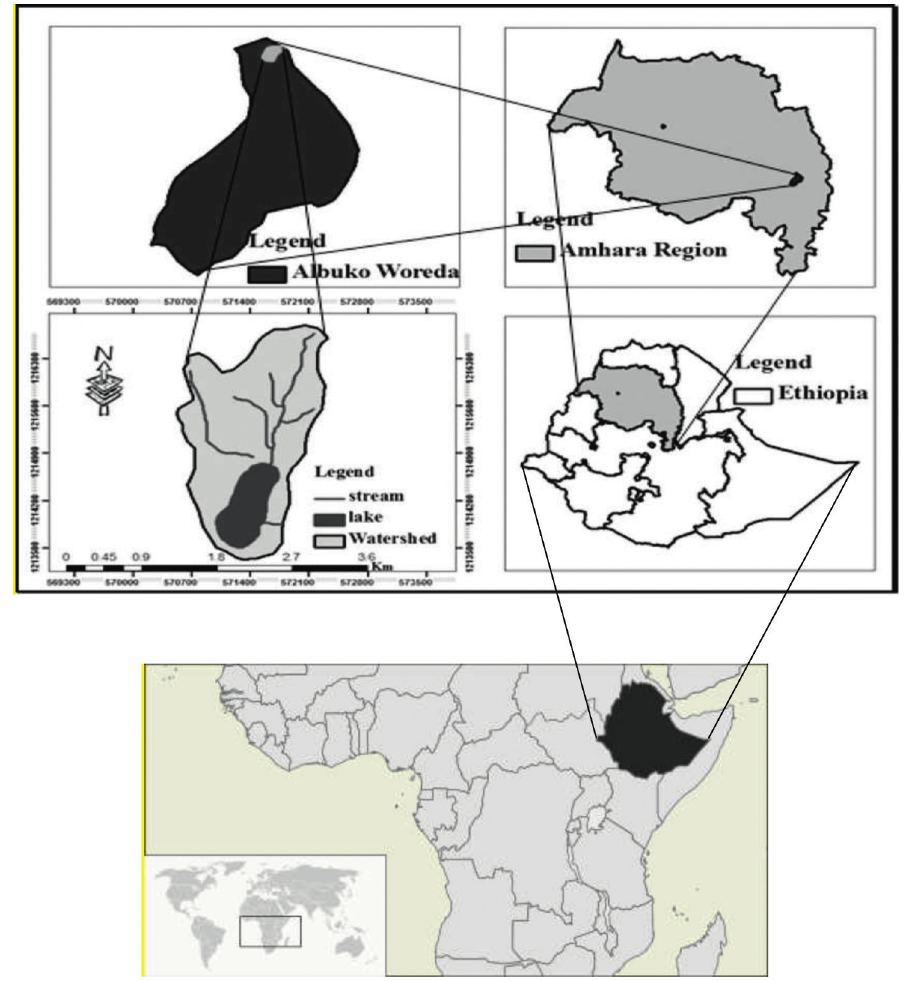
Figure 1: A map of the study area (adapted from Addis et al.